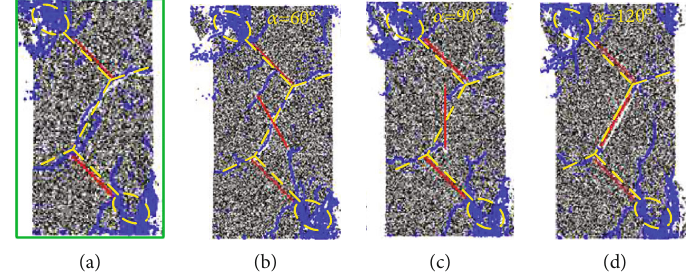
Figure 17: Comparison of the failure mode of double-crack and triple-crack